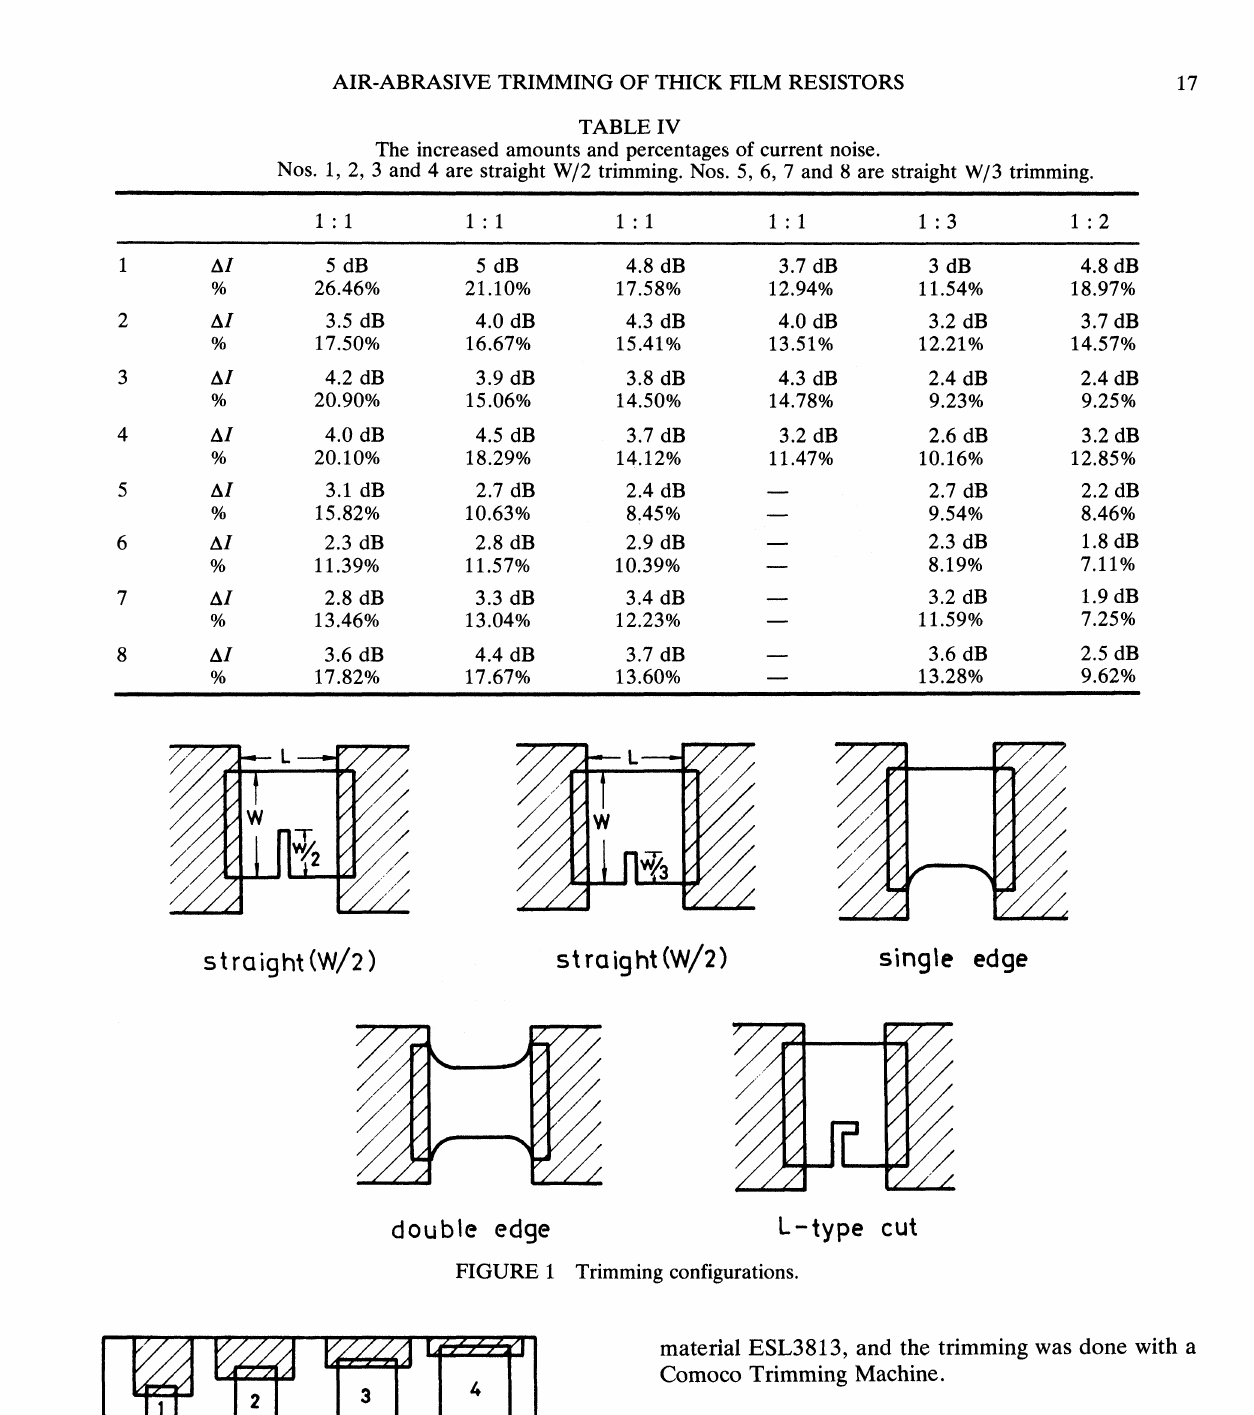
FIGURE Trimming configurations. material ESL3813, and the trimming was done with a Comoco Trimming